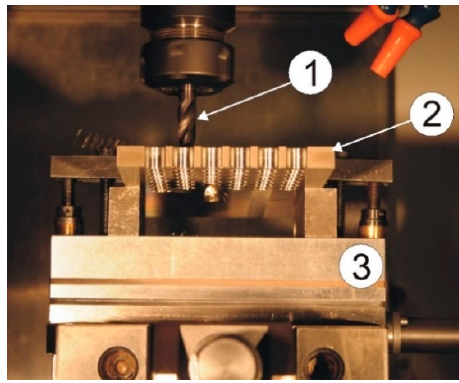
Figure 3. Method of mounting the dynamometer in a machine tool. 1—drill, 2—workpiece, 3— dynamometer.